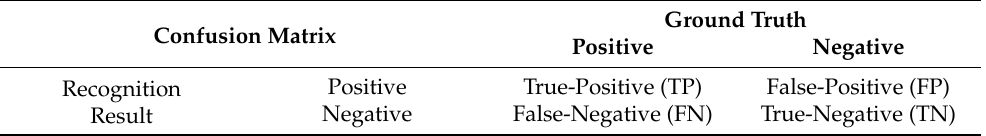
Table 2. Confusion matrix for binary classi fi cation.